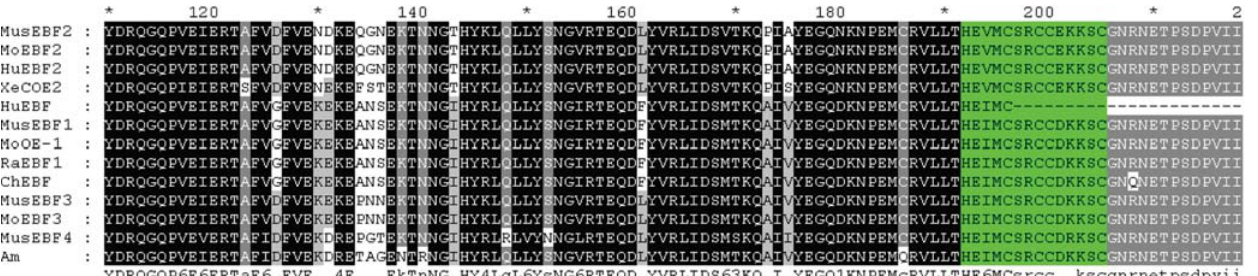
Figure 6. Alignments of DNA binding domain. The zinc finger motif was colored with green. The consensus sequence was under the alignments. Accession number for the COE family members are as following: NP_034225, MusEBF2; NP_073150, HuEBF2; AAH41178, HuEBF; NP_031923,